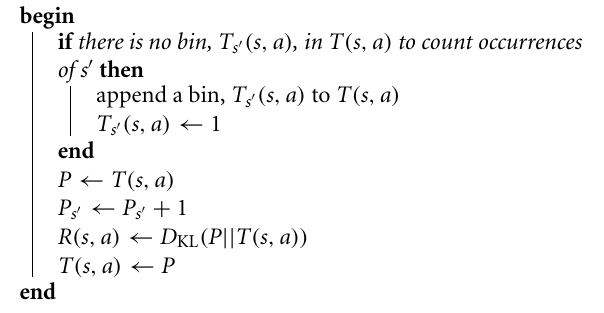
Algorithm 1: Observe( s , a , s (cid:7) , T ( s , a ) , R ( s , a ) )